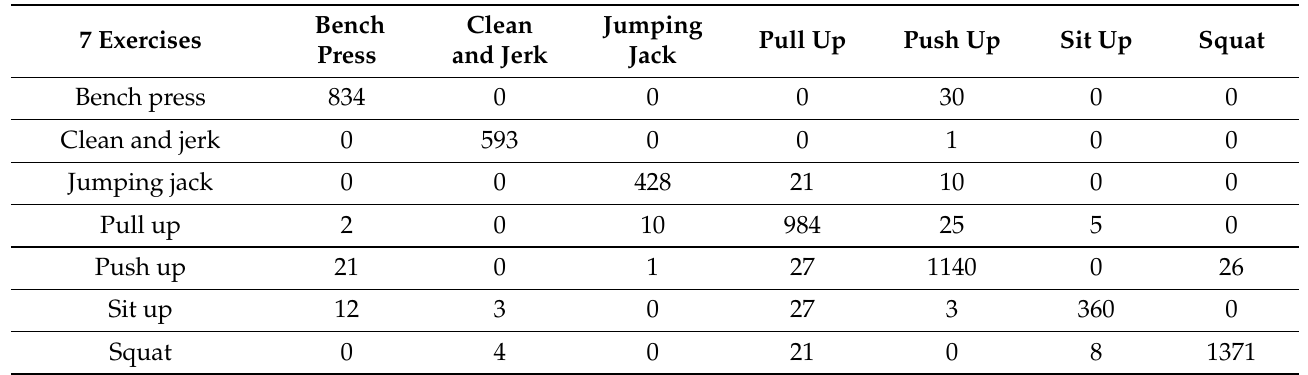
Table 2. Confusion matrix for exercise recognition across 7 exercises.